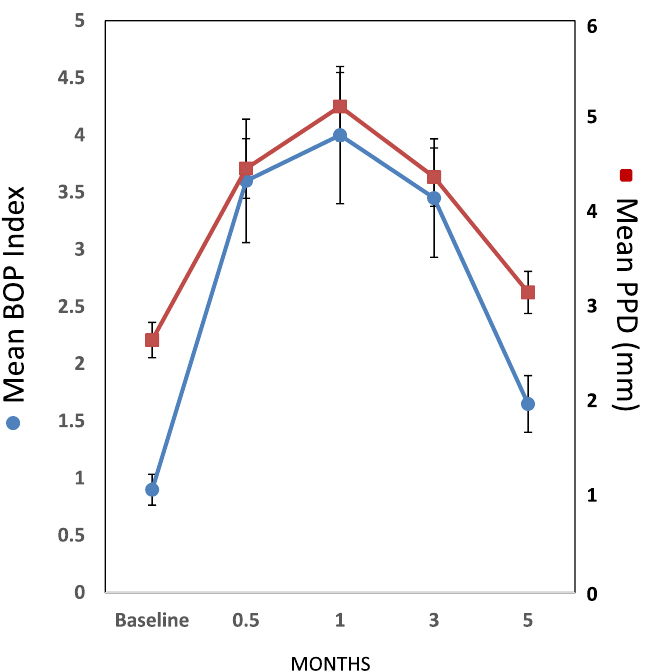
Figure 2. Clinical features of inflammation (bleeding on probing, BOP) and destructive disease (probing pocket depth, PPD) in ligated sites of the nonhuman primates. Ligatures were removed after clinical measures at 3 months, with 5 month samples representing clinical resolution. The points denote the mean values from 18 animals and the vertical brackets enclose 1 SD.